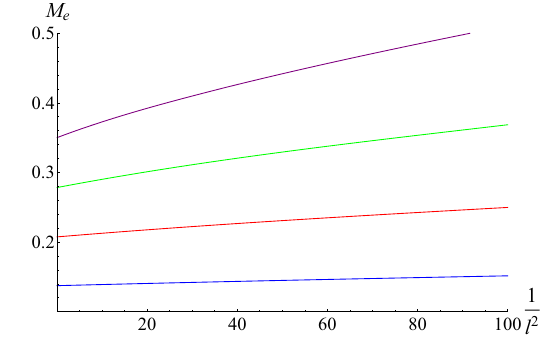
Fig. 2 Plots of the extremal radius (left) and the extremal mass (right) in terms of the inverse squared curvature radius 1 values of the characteristic parameter k of the non-linear electrodynam-